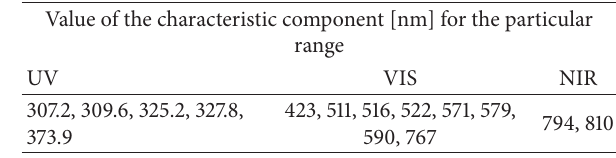
Table 1: Dominant wavelength components [nm] occurring in the considered